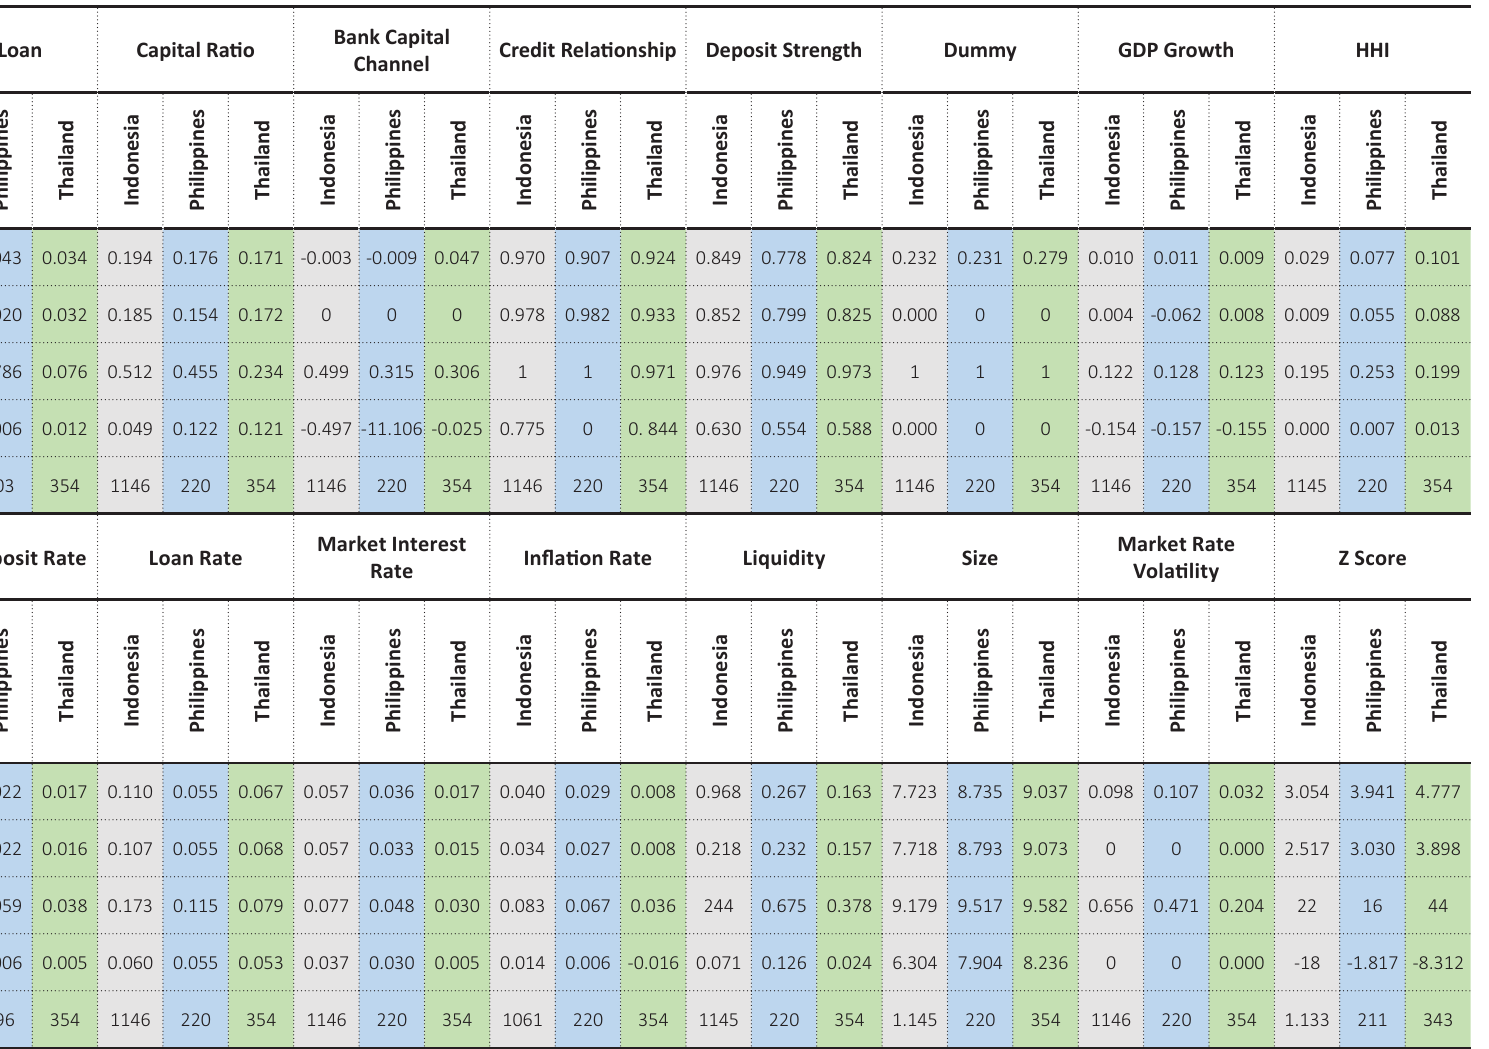
Table A1. Descriptive statistics from equation 1 (Loan